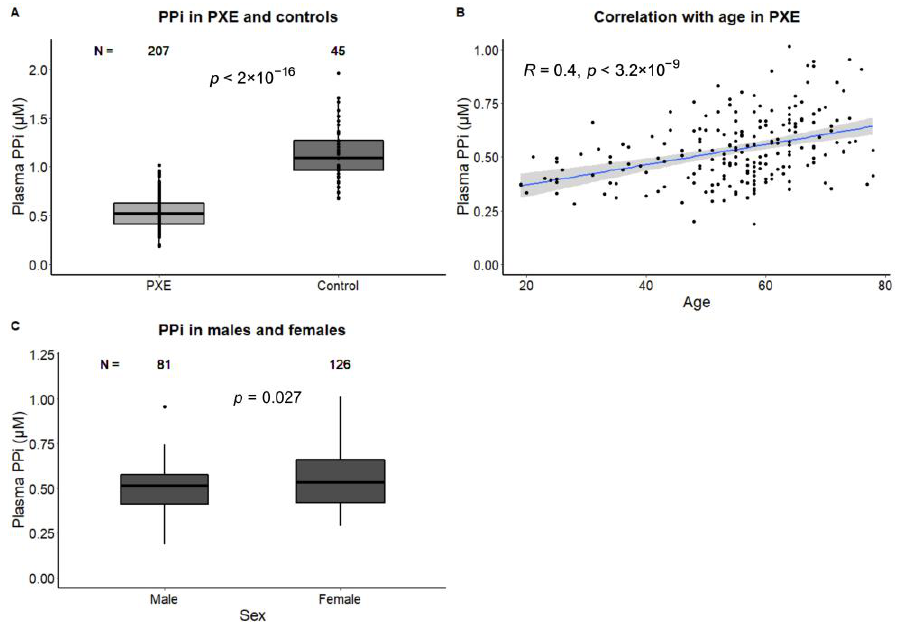
Figure 1. Inorganic pyrophosphate in PXE and controls. Plasma PP i is approximately 60% lower in PXE patients than in controls ( A ). Plasma PP i is correlated with age in PXE ( B ) and female PXE patients have slightly higher PP i ( C ). Data were analyzed with Student’s t -test (categorical variables) or the Pearson correlation (continuous variables). A p -value < 0.05 was regarded as statistically sig- nificant.